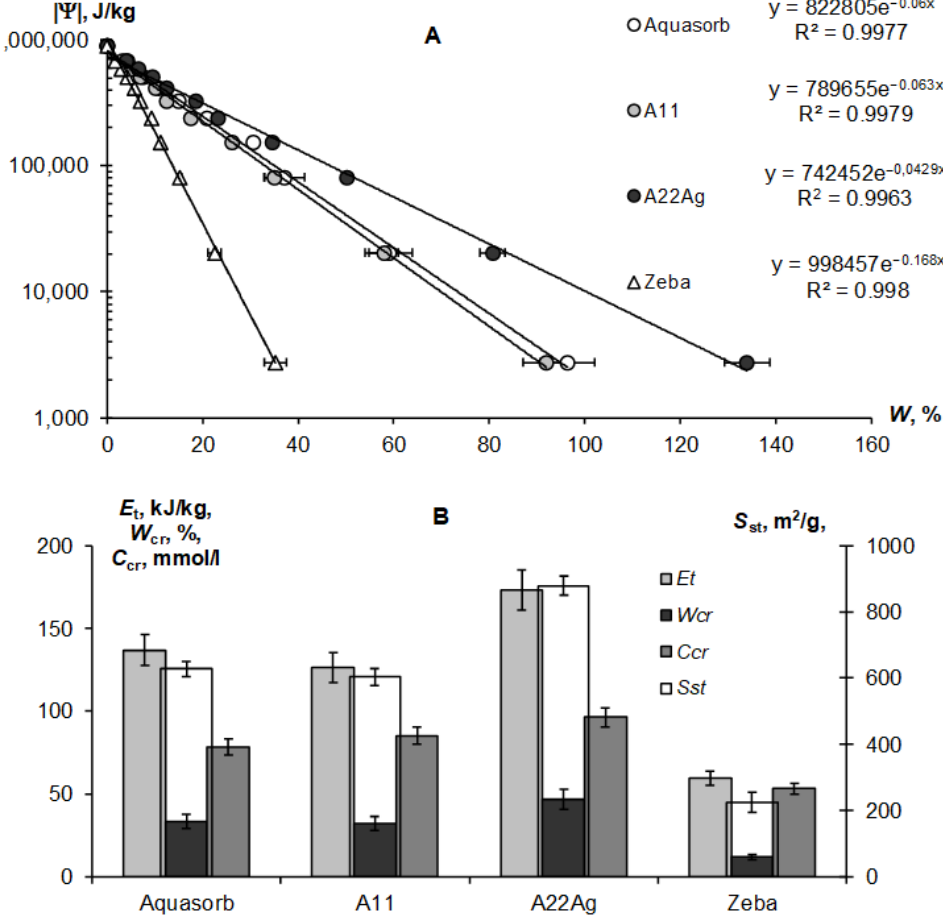
Figure 4. Sorption part of the WRCs for compared hydrogels: ( A )–experimental data and their approximation using the fundamental Model (6); ( B )—calculated quality indicators.